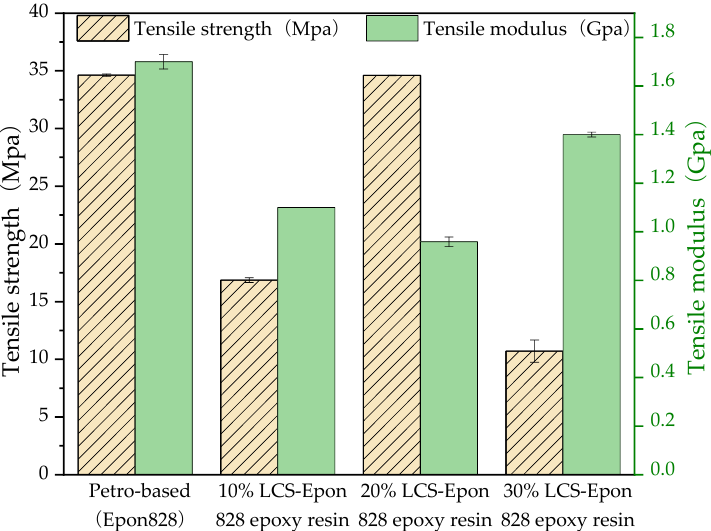
Figure 3. Tensile strength and modulus of the cured epoxy resins (LCS: liquefied cotton stalk).